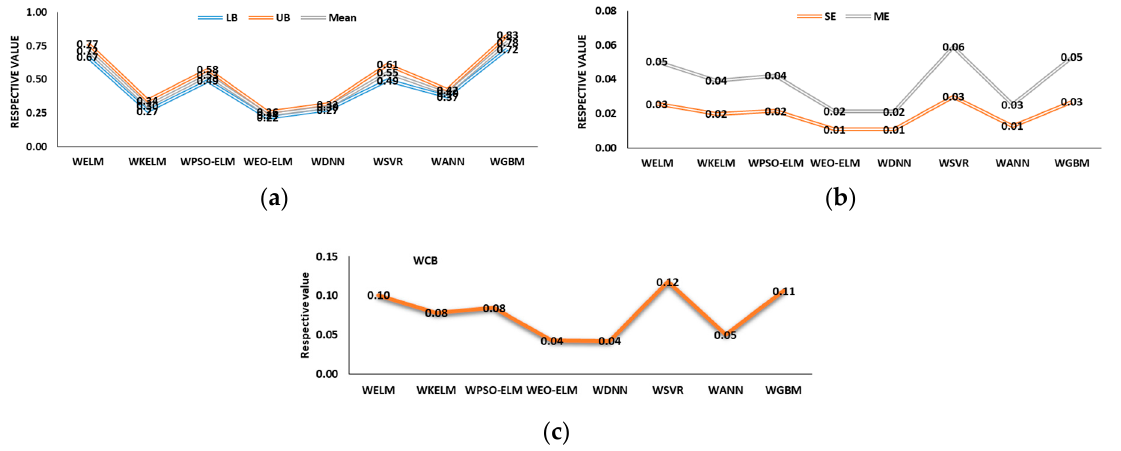
Figure 22. Visual representation of UA for wavelet-based models (Fal at Tregony), ( a ) LB, UB and Mean; ( b ) SE and ME; ( c ) WCB.